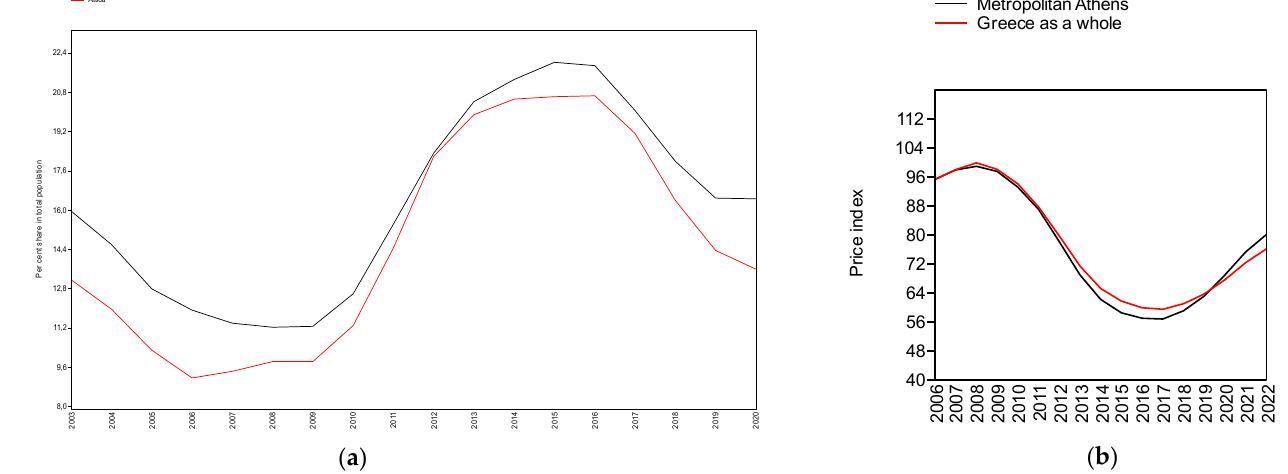
Figure 7. ( a ) Index of severe material deprivation (per cent share of people living in such conditions in total population) in metropolitan Athens and Greece as a whole (source: Eurostat regional statistics); ( b ) average price index (2008 = 100) of residential apartments over time (2006–2022) in the same spatial partitions (source: Bank of Greece).